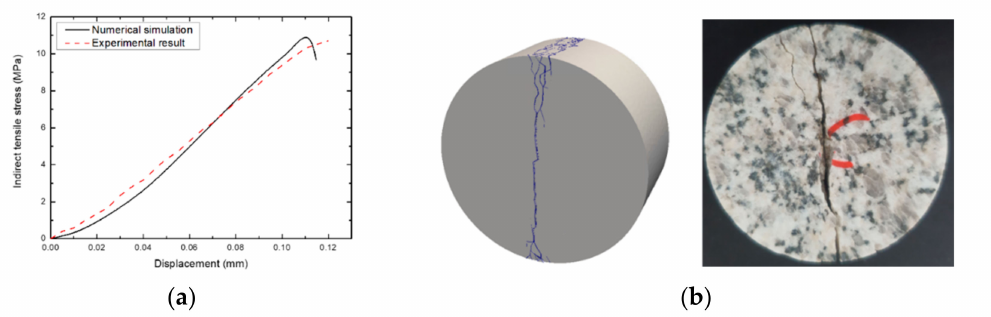
Figure 7. Comparison of FDEM numerical simulation and experiment of the BTS test of granite under quasi-static loading: ( a ) plot of axial stress versus axial strain and ( b ) final fracture pattern from the numerical simulation and experimental